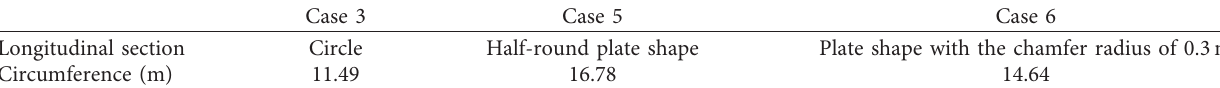
Table 5: The structural parameters of three brace